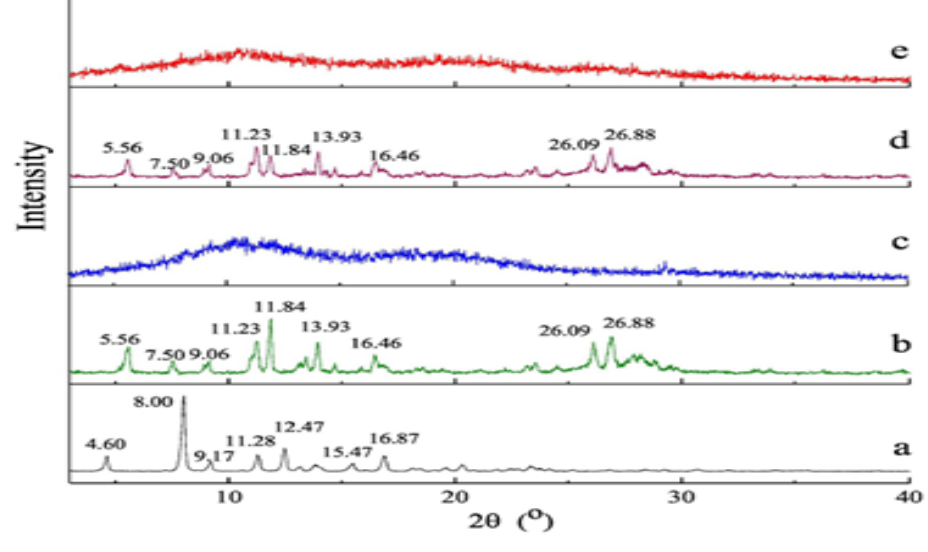
Figure 2. PXRD patterns of (a) crystalline docetaxel, (b) crystalline myricetin, (c) amorphous docetaxel, (d) rotary evaporation product of myricetin, and (e) co-amorphous docetaxel- myricetin (81